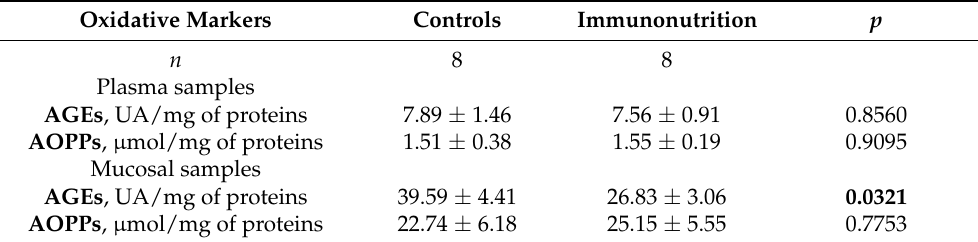
Table 3. Mean values of oxidative markers in plasma and/or mucosa samples of Crohn’s disease patients. Oxidative